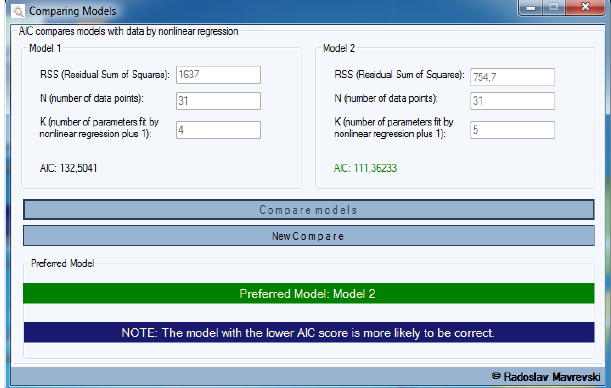
Fig. 2. Example for calculation of the AIC: dialogue box of the program “Comparing Models” for calculating AIC.